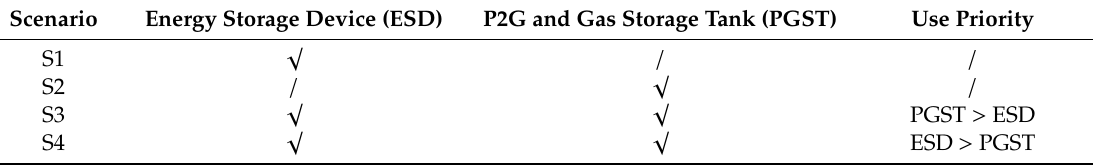
Table 1. Four scenarios based on di ff erent types of storage equipment and their use priorities.